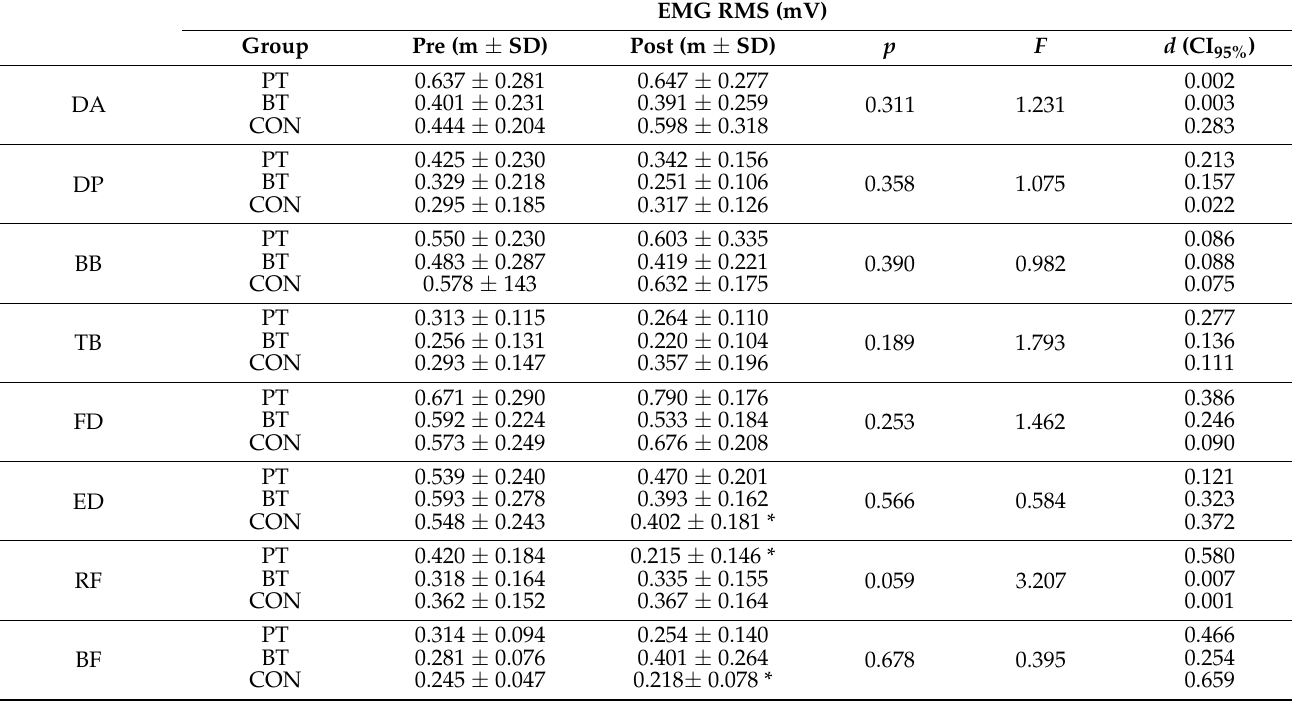
Table 6. Changes in the EMG root mean square (RMS) in each muscle during the stroke test after the 8-week intervention.